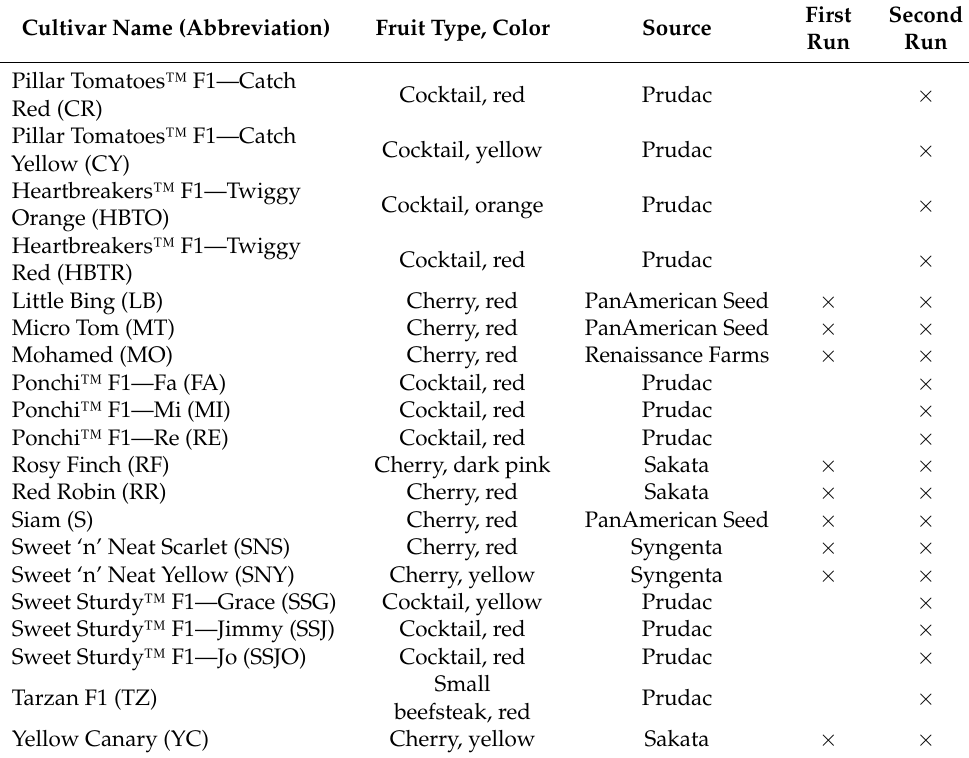
Table 1. Name and source of tomato cultivars included in the first and second experimental